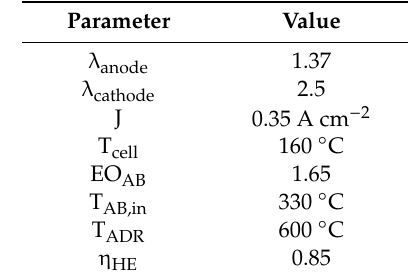
Table 2. Nominal operating parameters of the system.